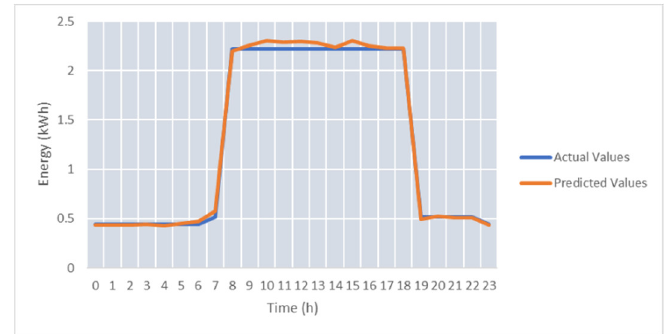
Figure 8. TC-S1: best day predicted (SMAPE = 2.44%).